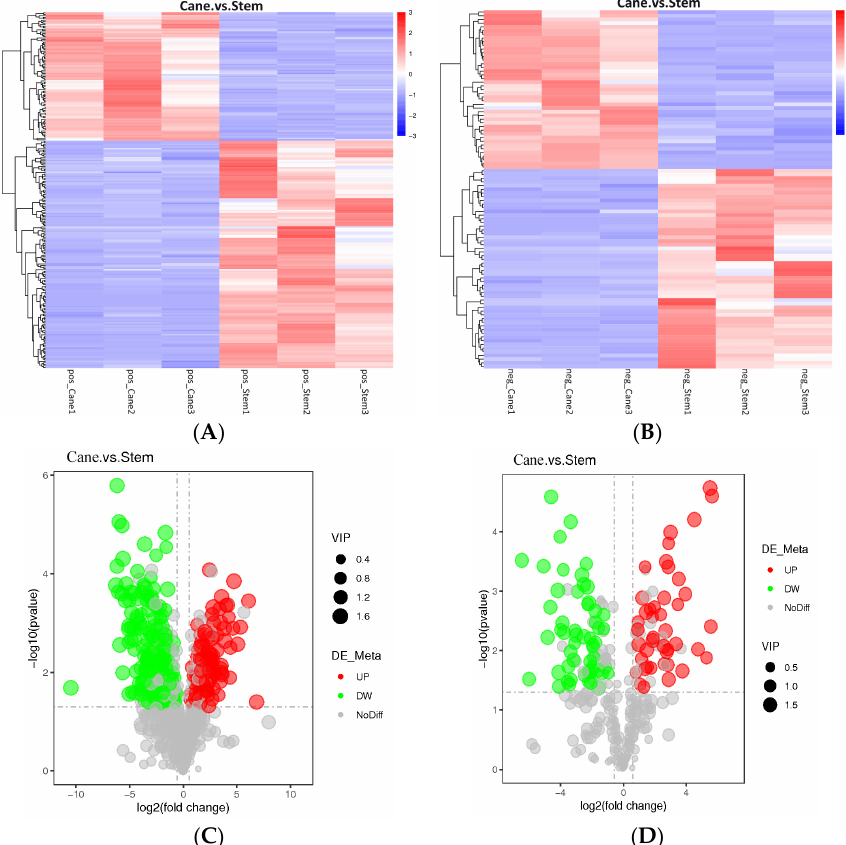
Figure 1. An overview of the metabolic profiles of V. davidii Foex cane and stem samples. ( A ) Cluster heatmaps of different samples, generated based on various metabolites, in the positive mode. ( B ) Cluster heatmaps of different samples, generated based on various metabolites, in the negative mode. ( C , D ) Comparative metabolic profile volcano diagram. The red, green, and gray circles represent the up-regulated, down-regulated, and insignificant metabolites, respectively. The horizontal axis represents the fold change in metabolites, and the vertical axis represents the significance level. Comparison of Sample1. vs. Sample2 illustrates the differences between metabolites in the former (Sample1) and the latter (Sample2).